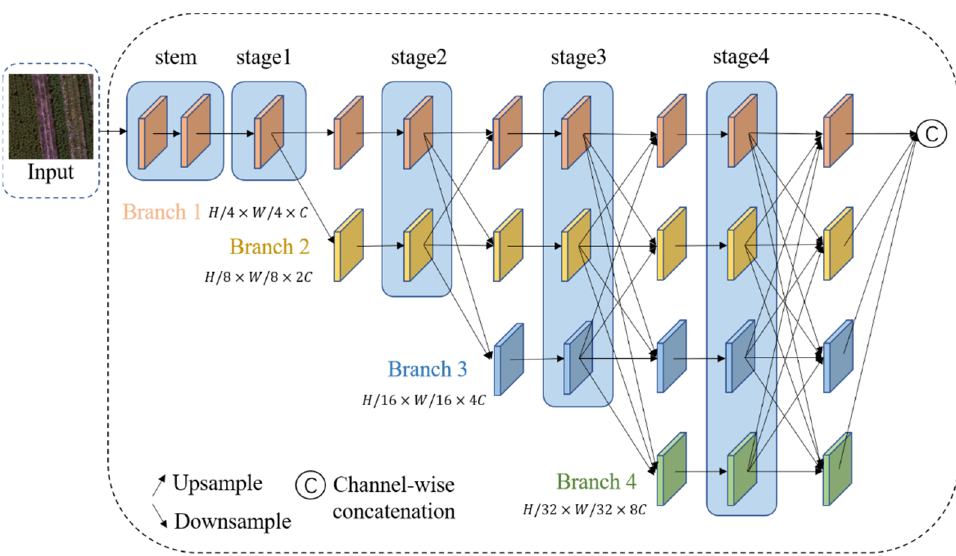
Figure 6. The backbone network of the semantic segmentation model: HRNet.